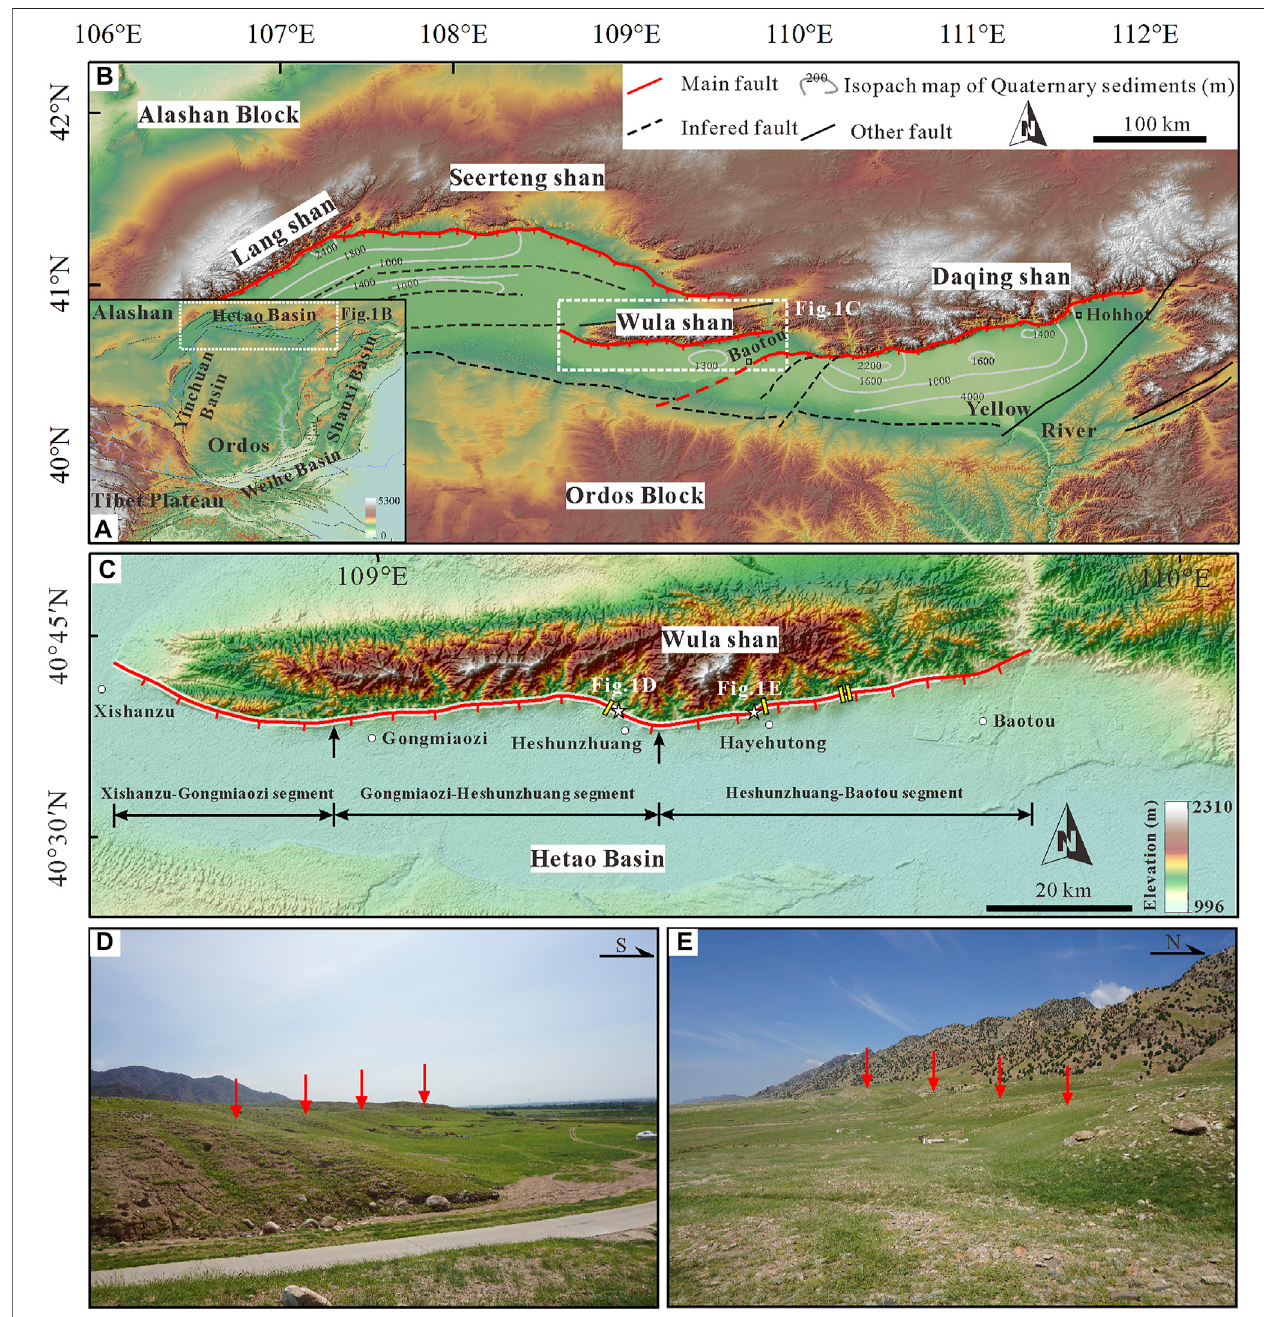
FIGURE1|(A) Location oftheHetaoBasinwhichissuitedatthenorthernmarginoftheOrdosBlock. (B) DistributionofmajoractivestructuresintheHetaoBasin. The fault traces are modi fi ed from previous studies (Chen, 2002; Ran et al., 2003; Dong et al., 2018; He et al., 2018; Rao et al., 2020). (C) Geometry of the Wulashan Piedmont Fault. The black arrows mark the two bedrock bulges which have divided the fault into three individual segments. The yellow squares indicate previous paleoseismictrenchingsitesofChen(2002)andRanetal.(2003).ThewhiteswathdenotesthecoverageoftheLiDARtopography. (D) and (E) show fi eldphotosof fault scarps developed along the Wulashan Piedmont